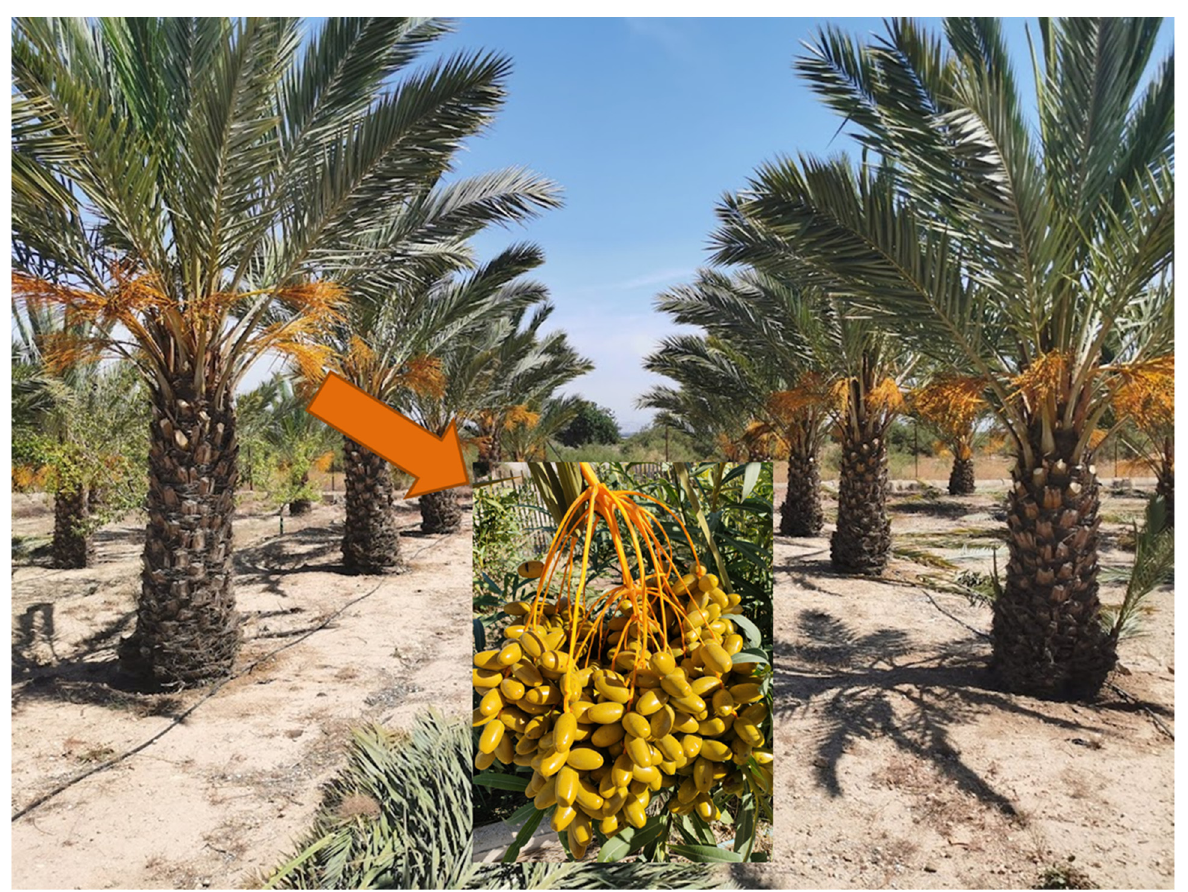
Figure 1. Elche palm grove (UNESCO World Heritage Site) in full production; a bunch of date fruits has been highlighted.